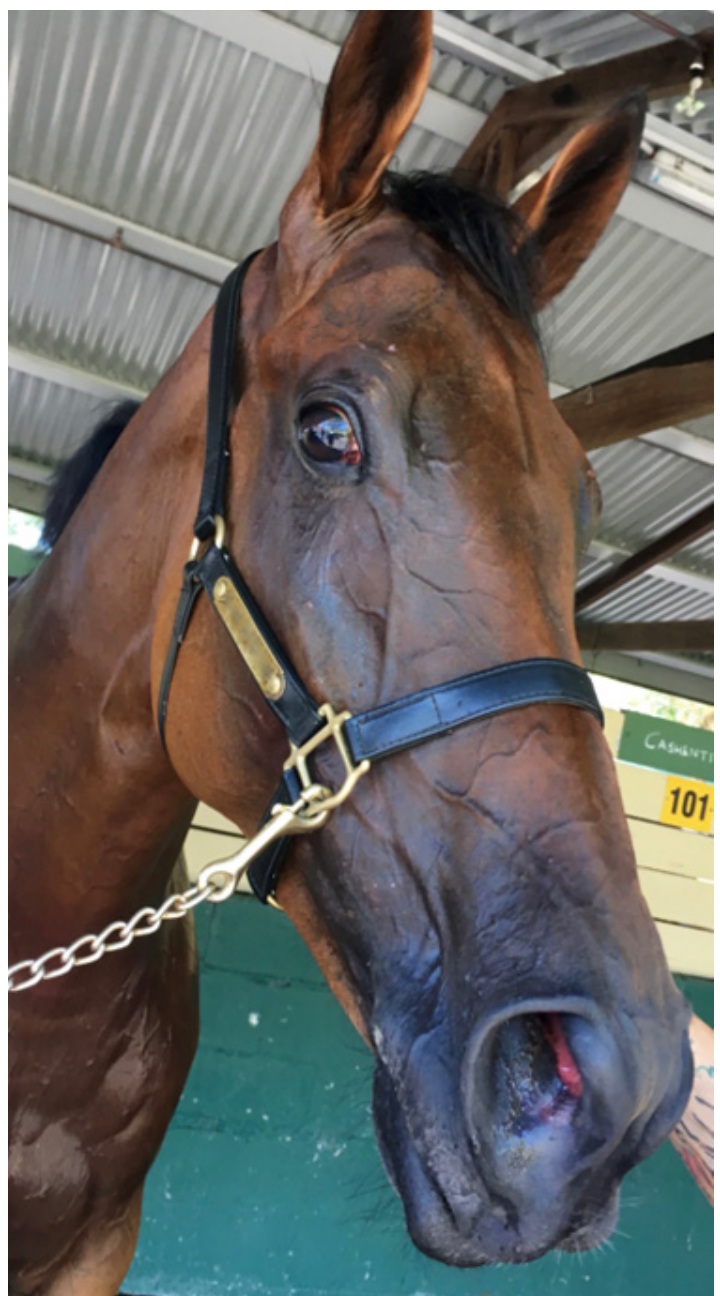
Figure 4. This horse finished racing 10 min previously and exhibits a ‘panting’ type of